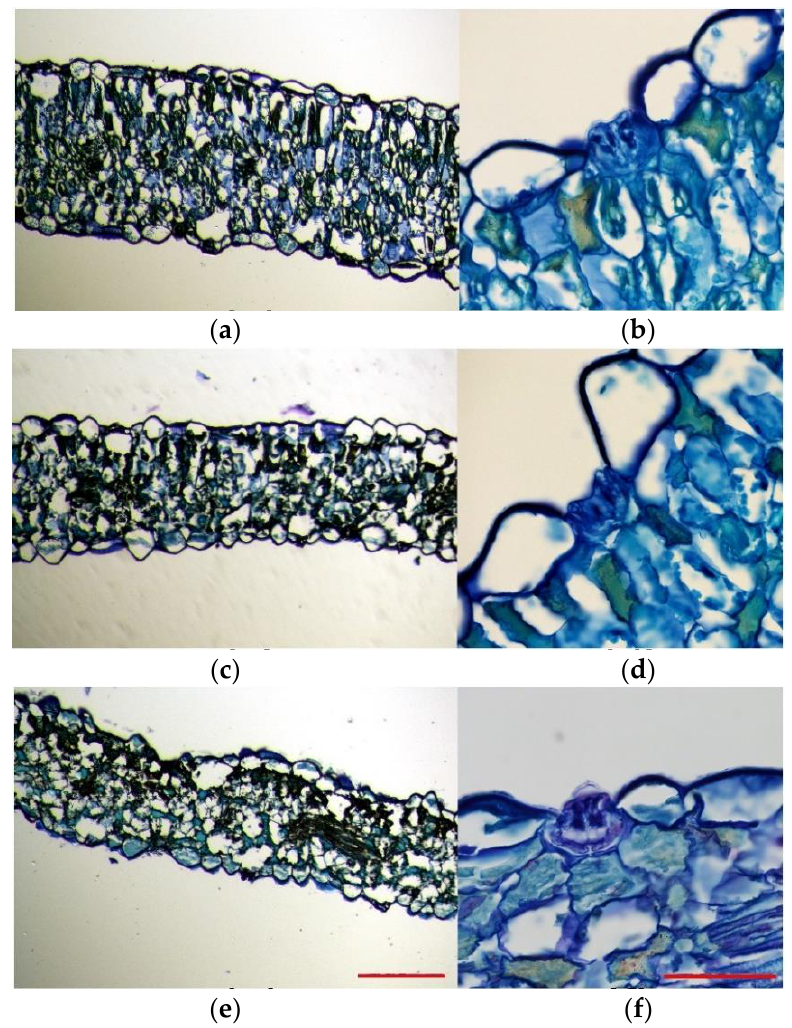
Figure 4. Toluidine blue staining of 8 mm leaf cross-sections of Limonium angustebracteaum plants under ( a , b ) control conditions, ( c , d ) after one-month 600 mM NaCl treatment and ( e , f ) after one- month water deficit treatment. Scale bar ( a , c , e ) 500 μm, and ( b , d , f ) 50 μm (n = 3).